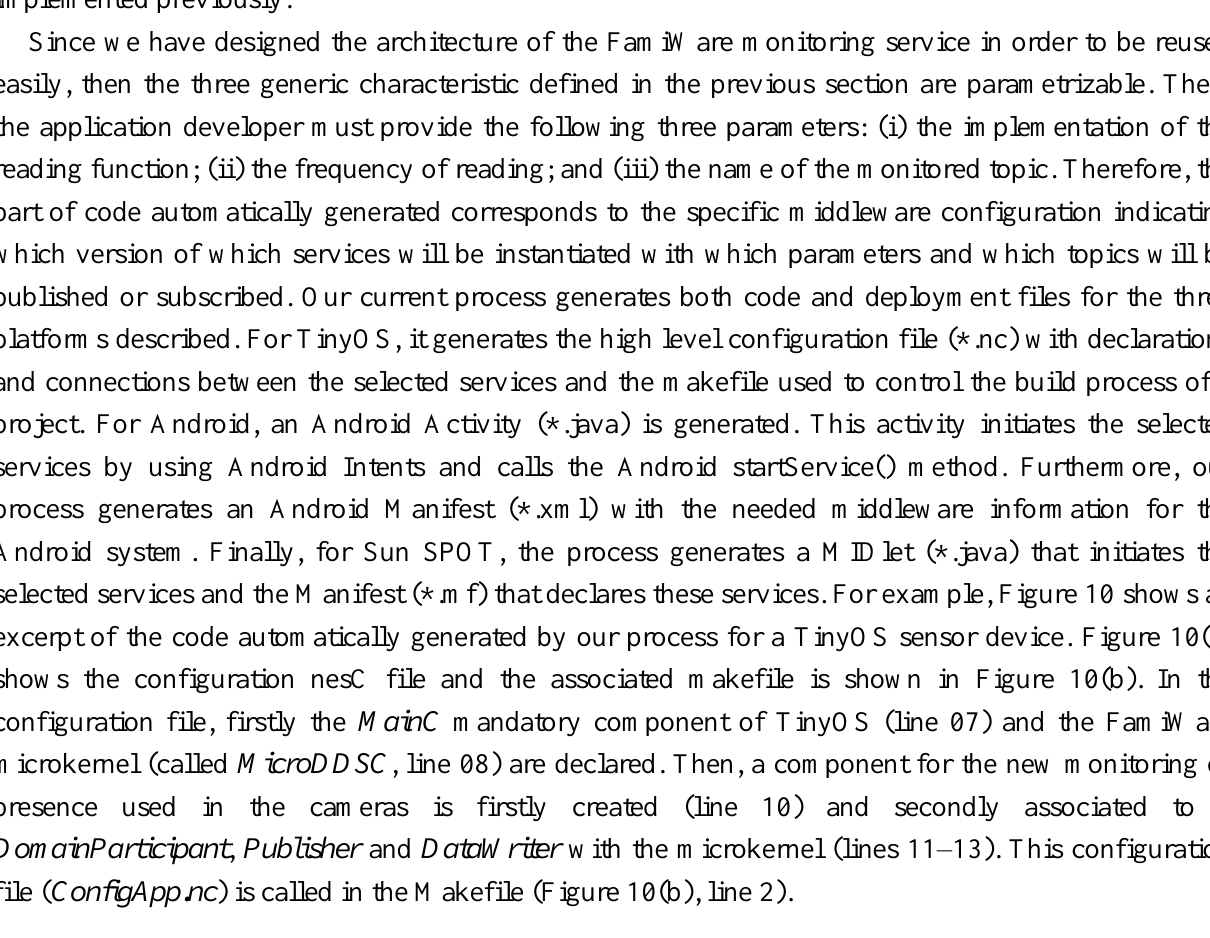
Figure 10. FamiWare code automatically generated for TinyOS